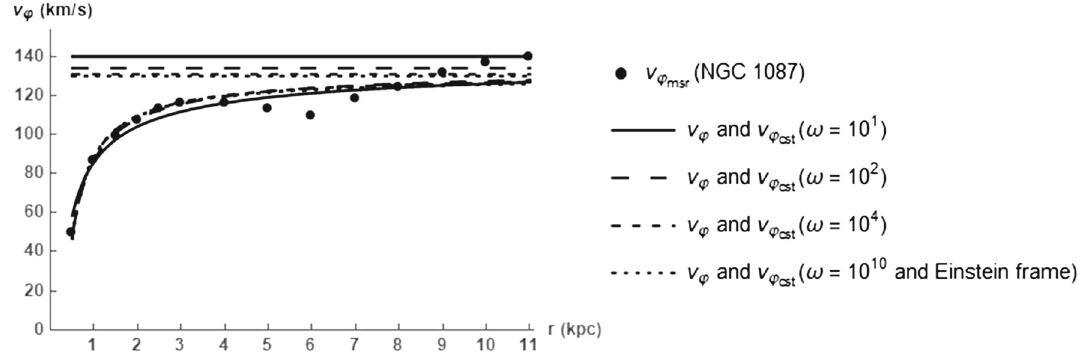
Fig. 4 Stars velocities of the NGC 1087 galaxy [10] compared to the best fits of the function (48) in the Jordan–Fierz frame. The values of the constants and the coefficients of determination are in the Table 2. From ω = 10 2 , the fit of the function (48) results in almost identical curves Table 2 Values of the constants and the coefficients of determination for the fits of the function (48) in the Jordan–Fierz for NGC 1087 galaxy, shown in Fig. 4. The constant C 1 was defined by the system of Eqs. (25), (65) and (71), and C 5 was defined by Eq. (58) NGC